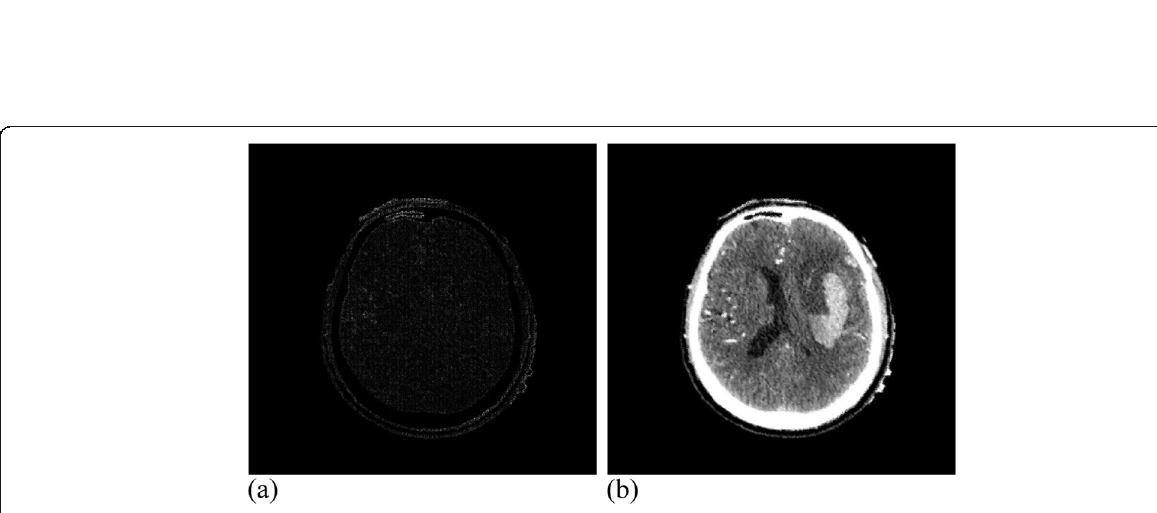
Fig. 15 CT data after registration. ( a ): Difference between CT reference image and registration image; ( b ): CT registration